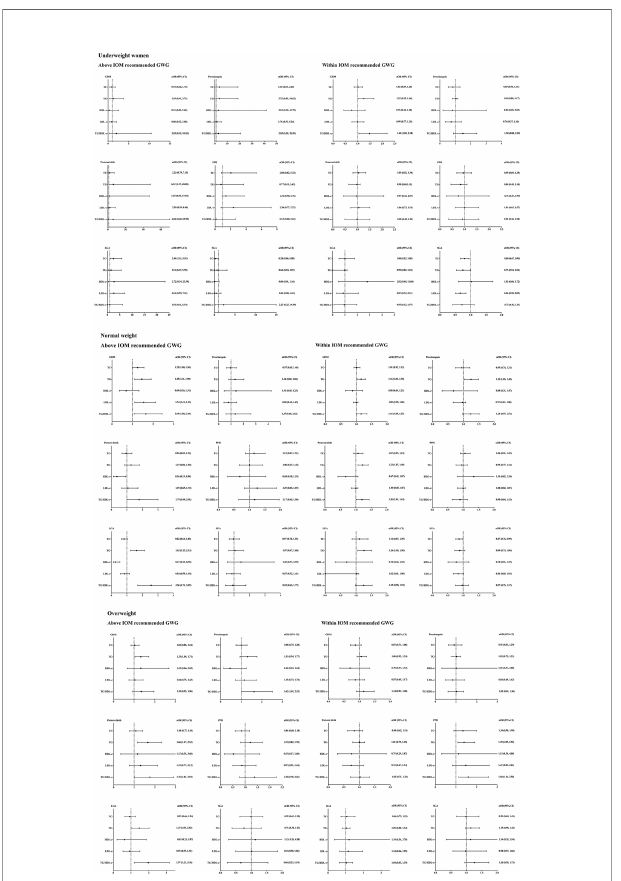
FIGURE 3 | Lipid pro fi les during second trimester and pregnancy complications strati fi ed by pre-pregnancy BMI and gestational weight gain. BMI, body mass index; aORs, adjusting odd ratios; IOM, Institute of Medicine; GWG, gestational weight gain; GDM, gestational diabetes mellitus; PPH, postpartum hemorrhage; LGA, large for gestational age; SGA, small for gestational age; TC, total cholesterol; TG, triglycerides; HDL-c, high-density lipoprotein cholesterol; LDL-c, low-density lipoprotein cholesterol. Included subjects were grouped into underweight (<18.5 kg/m 2 ), normal-weight (18.5-22.9 kg/m 2 ), and overweight ( ≥ 23 kg/m 2 ) by BMI before conception based on the WHO criteria for Asian populations fi rst. Subjects in each group were divided into two subgroups according to the total GWG which was categorized as above and within the IOM recommendations. All ORs were adjusted for maternal